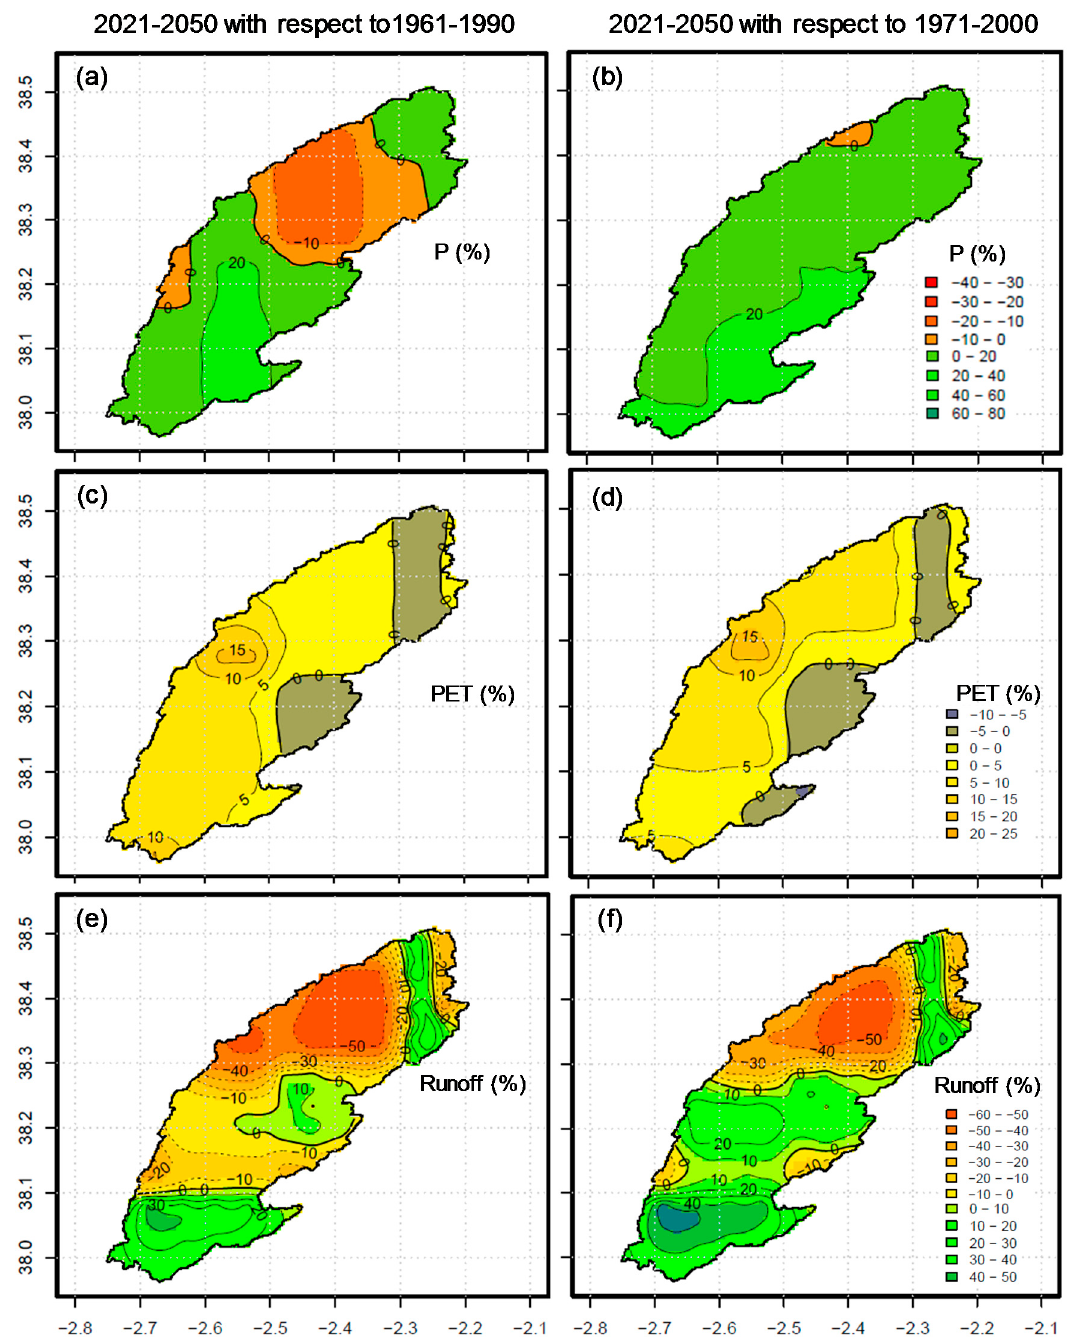
Figure 11. Spatial distribution of difference (%) of: ( a , b ) rainfall; ( c , d ) potential evapotranspiration;